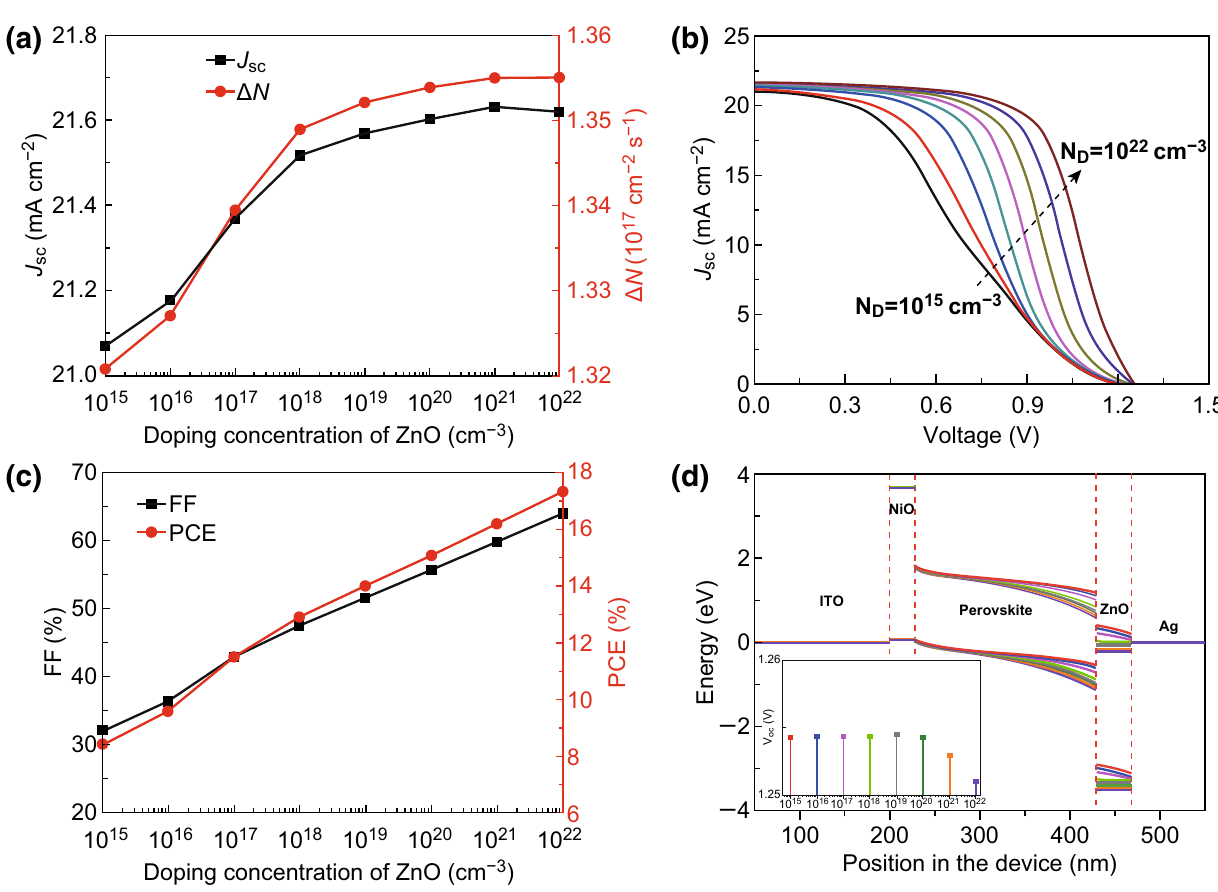
Fig. 5 a Short-circuit current density ( J sc ) and net carrier generation rate ( ΔN ), b J – V curves, c fill factor (FF) and power conversion efficiency (PCE), and d energy band diagrams coupled with open-circuit voltage V oc of CsPbI 3 -based PSCs at different doping